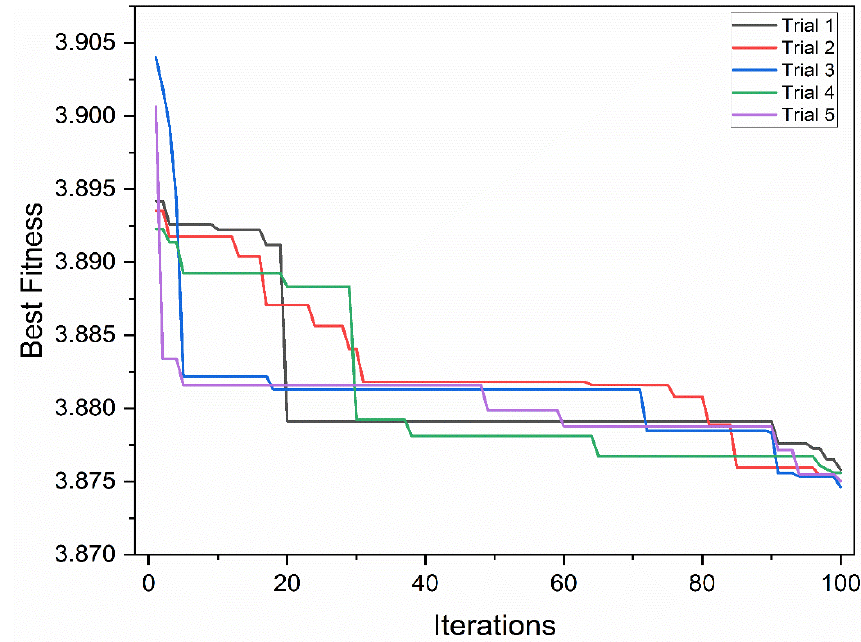
Figure 8. Convergence of five typical trials of GWO.